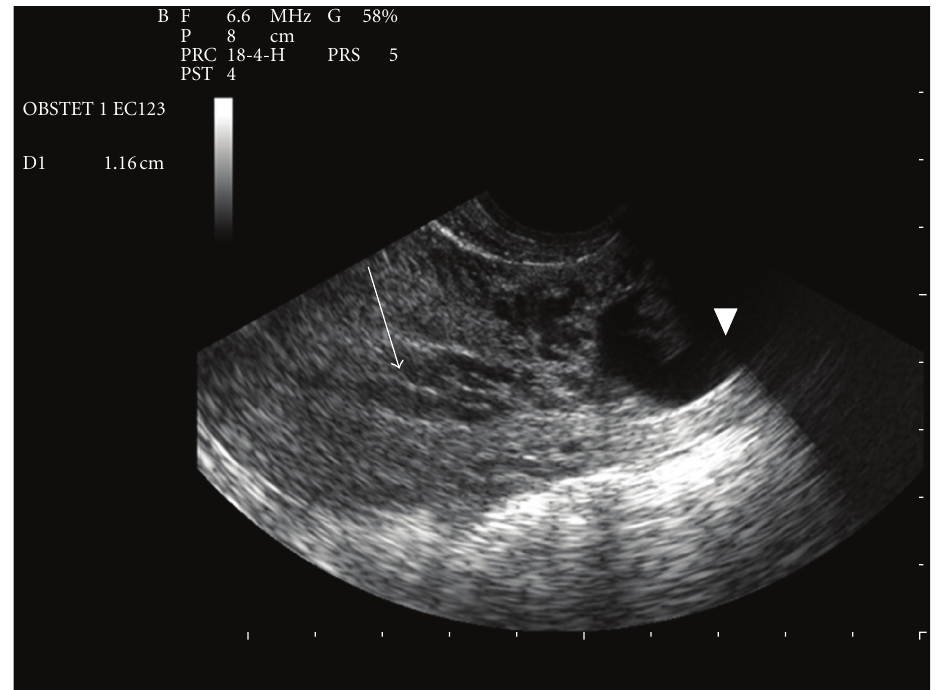
Figure 2: Transvaginal ultrasound image of the scar pregnancy. Gestational sac in the lower anterior wall of the uterus (arrow head), empty uterus